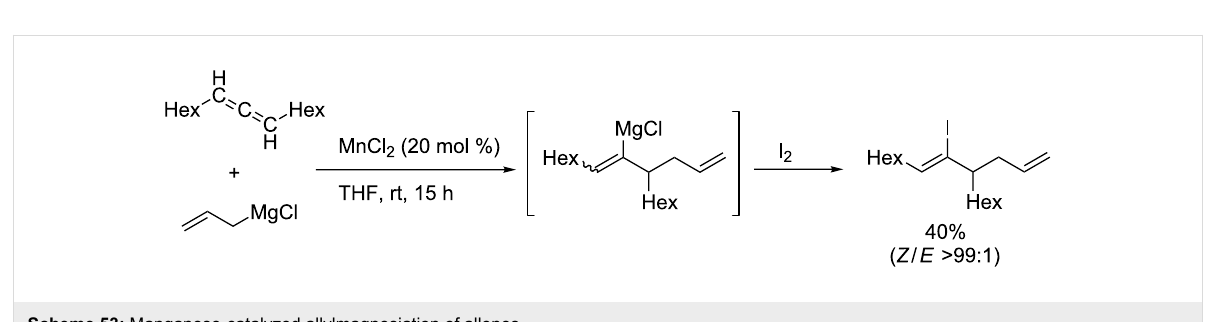
Scheme 53: Manganese-catalyzed allylmagnesiation of